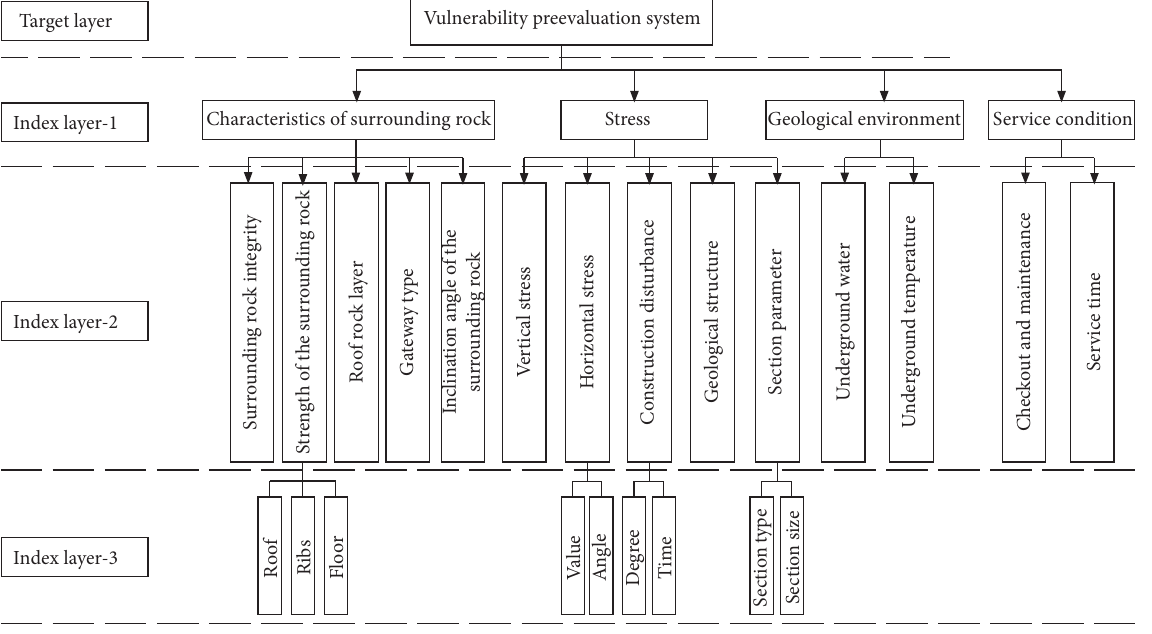
Figure 2: The preevaluation indexes of the surrounding rock vulnerability. Table 1: The scores of the surrounding rock integrity.